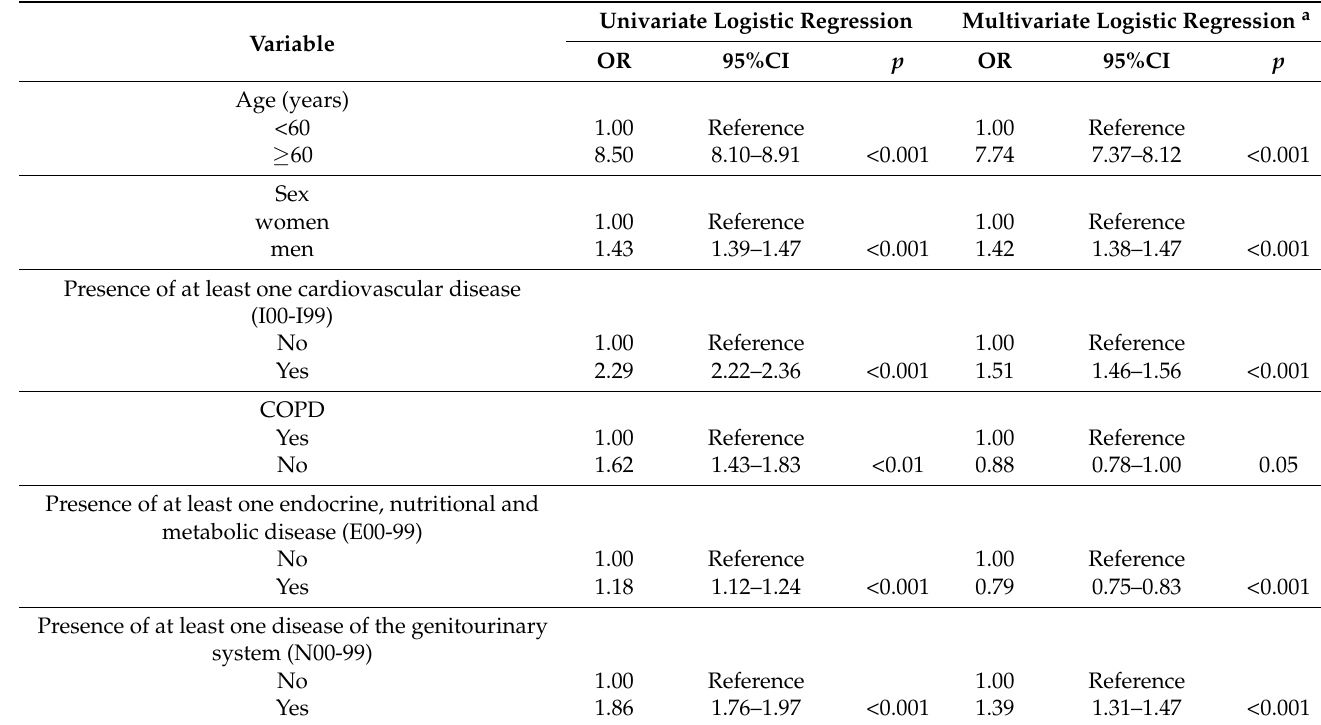
Table 2. Odds ratios (OR) and 95% confidence intervals (CI) for COVID 19–related risk of in-hospital death to selected factors in a group of 116,539 patients hospitalized with COVID-19—Poland, March–December 2020.